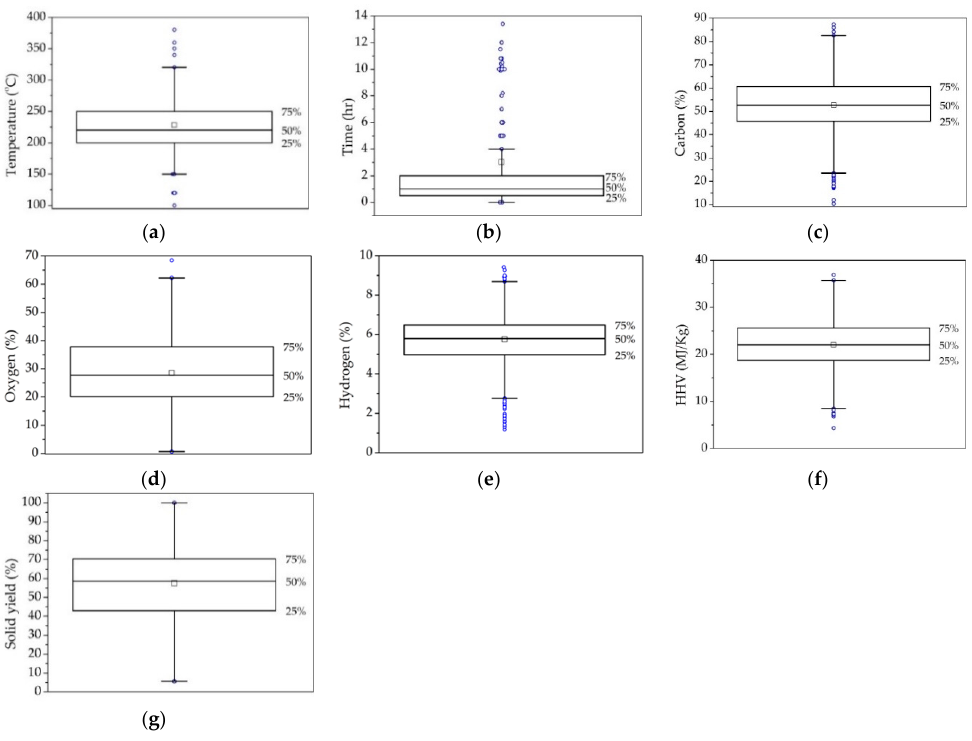
Figure 2. Boxplots of the values of ( a ) temperature, ( b ) time, ( c ) carbon, ( d ) oxygen, ( e ) hydrogen, ( f ) HHV, and ( g ) solid yield, related to hydrochar composition. Table 3. Biomasses used for the production of fuel hydrochar and included in data acquisition for the development of the artificial neural networks (ANN) models.